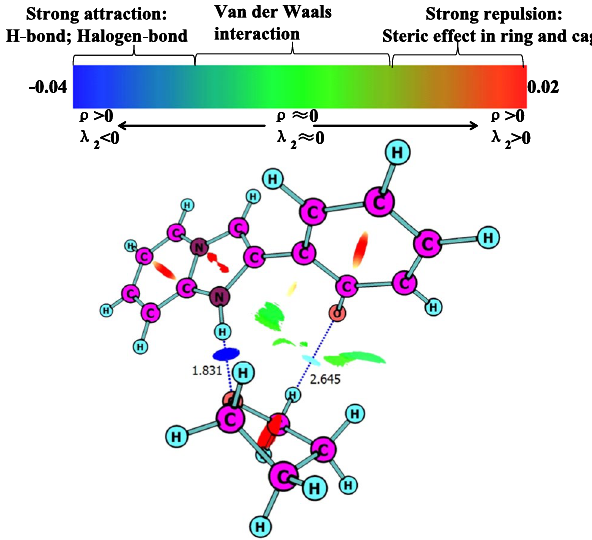
Figure 7. The visual diagram of RDG isosurface and the color gradient axis.